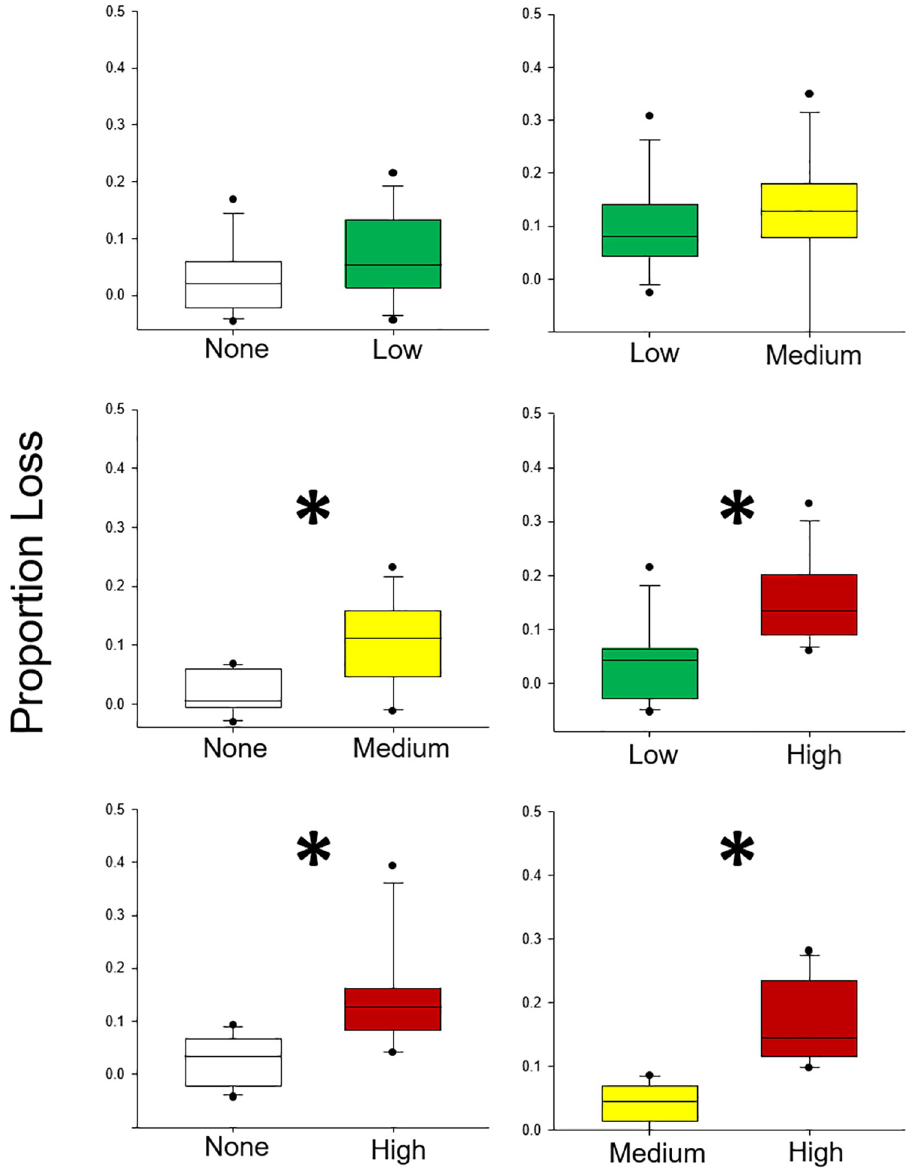
Fig 2. Results from Experiment 1: Grass shrimp. Paired choice experiments using grass shrimp ( P . pugio ) herbivores and plants grown in 4 oiled conditions: no (white), low (green), medium (yellow), and high (red). Asterisk indicates that a statistically significant difference